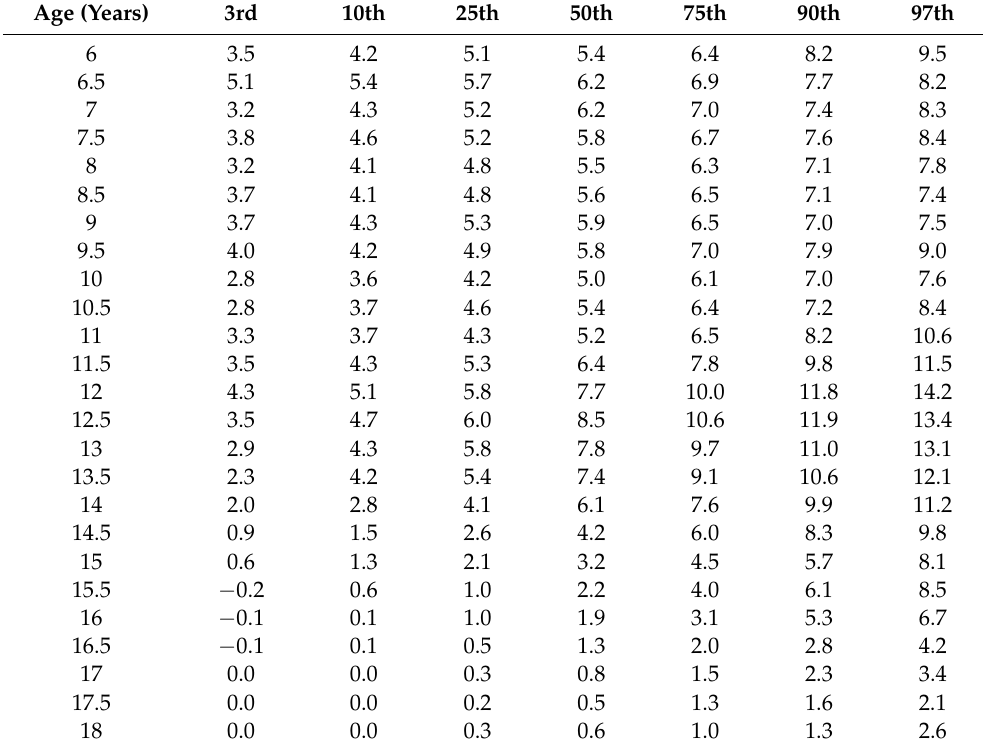
Table 3. Height velocity percentiles of schoolboys 6–18 years old.